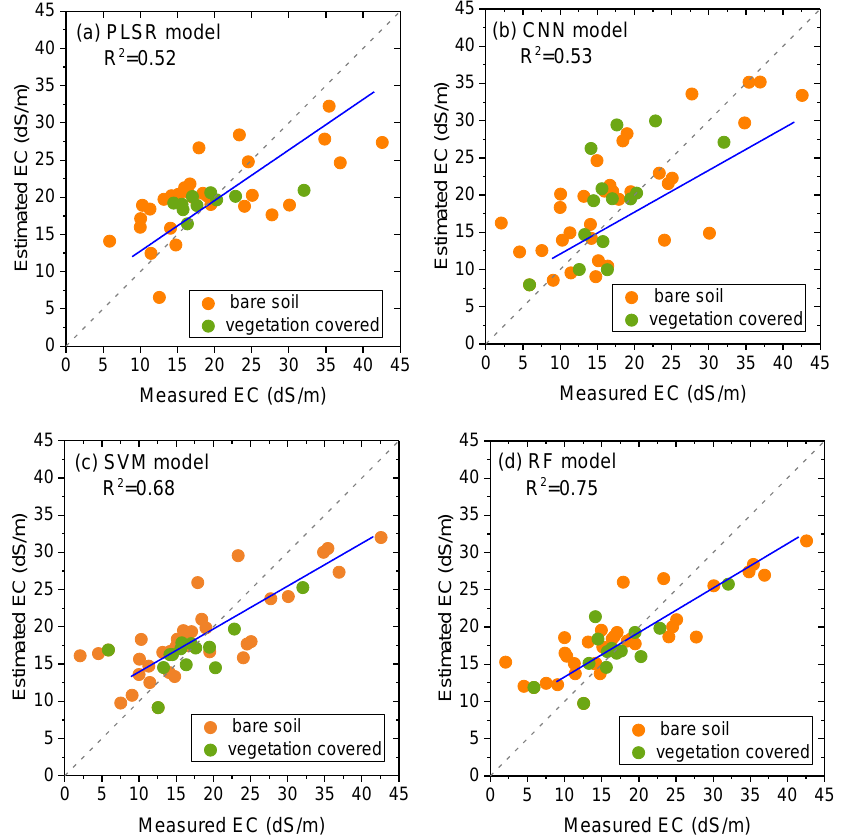
Figure 4. Performance of EC estimation by ( a ) PLSR model, ( b ) CNN model, ( c ) SVM model, and ( d ) RF model by soil samples in bare soil (orange) and vegetation covered